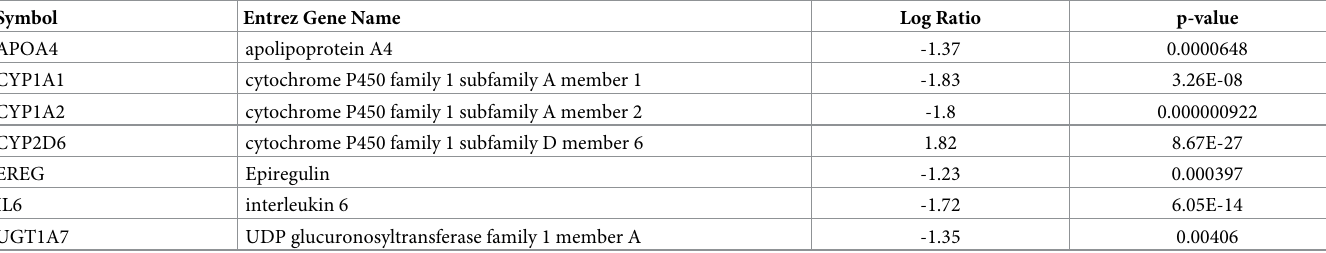
Table 3. Upstream network analysis of